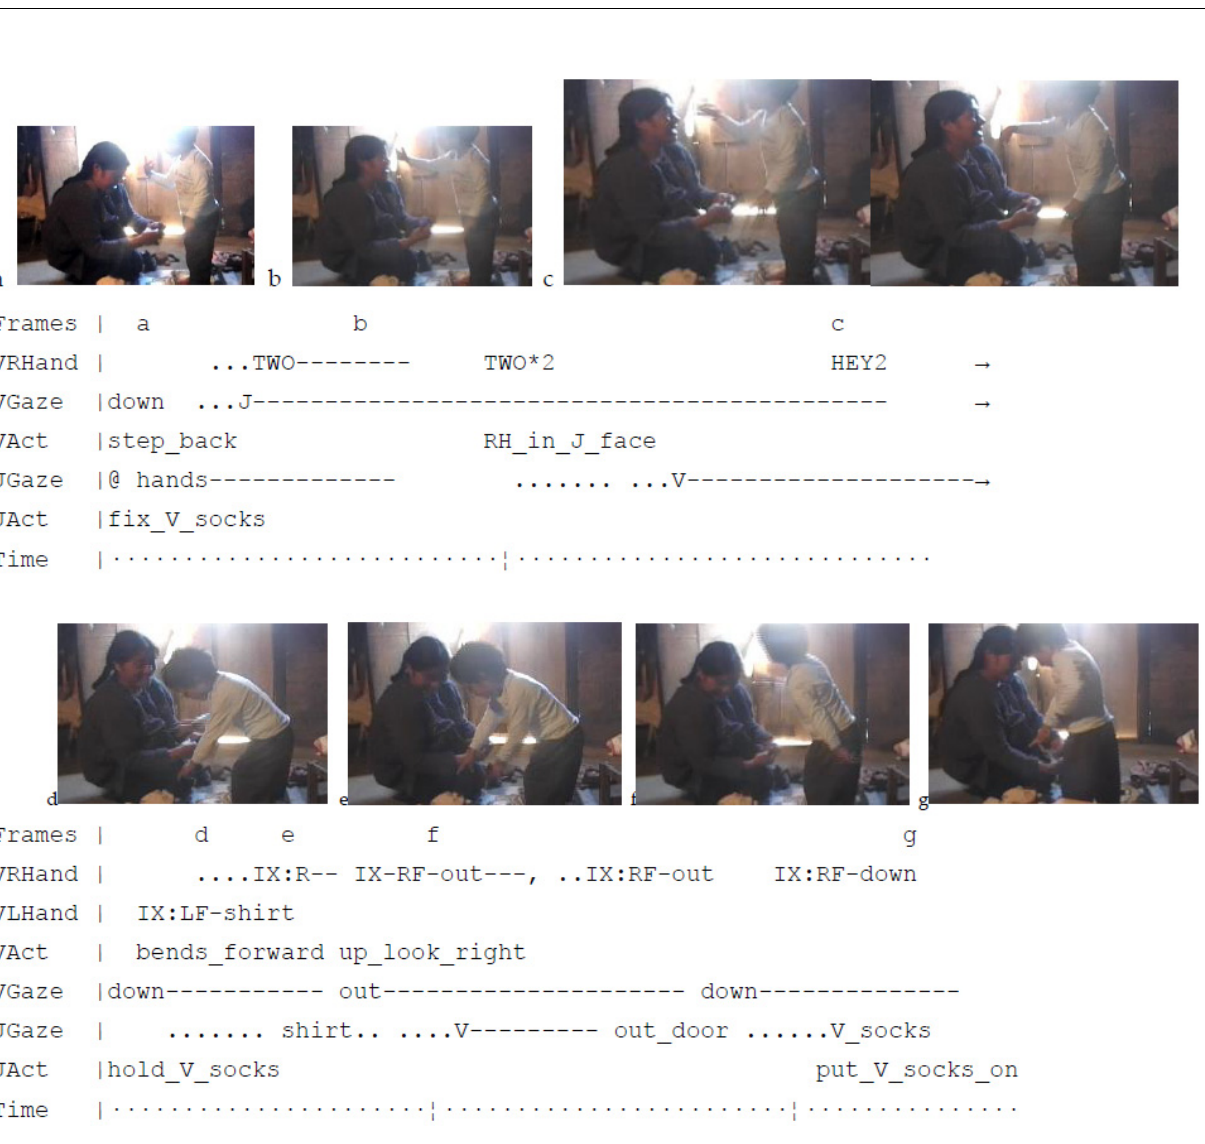
Figure 28. Vic asked for a different shirt, at 41 mons. ( a ) Vic formed a TWO sign right in front Jane’s face and ( b ) moved it into her line of sight. ( c ) Gazing at her, he quickly turned his TWO hand to face palm down and delivered to Jane a very quick HEY2, now having her full attention and intending to utter his main message. ( d ) He pointed down with his left hand to the shirt bundled on the floor, ( e ) switched hands to point at it with his right hand, ( f ) and then pointed from the shirt out the door and ( g ) back.